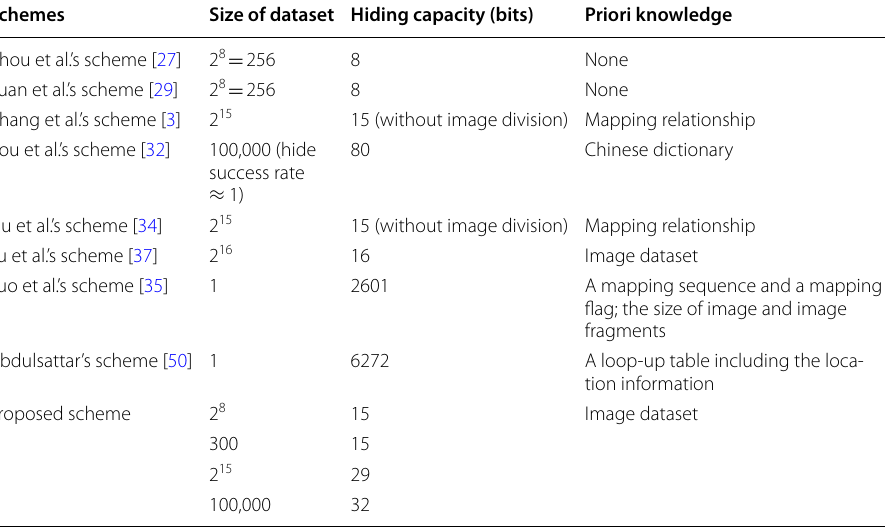
Table 7 Comparisons with the state‑of‑the‑art on hiding capacity under different priori knowledge and dataset